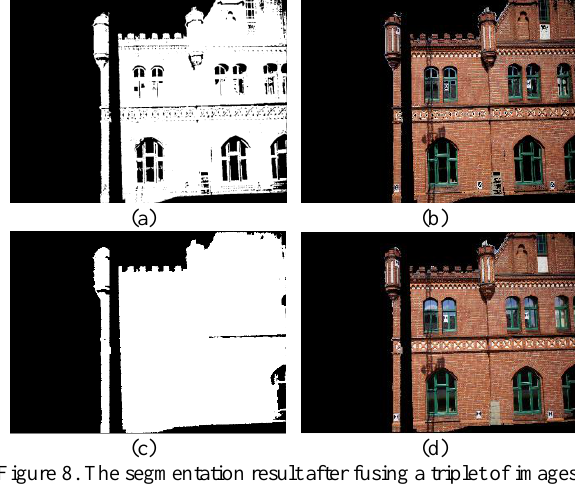
Figure 8. The segmentation result after fusing a triplet of images and using Grabcut. (a) Binary map for the segmentation using three images, (b) Segmented object using three images, (c) binary map for the segmentation after Grabcut (d) Segmentation after Grabcut.